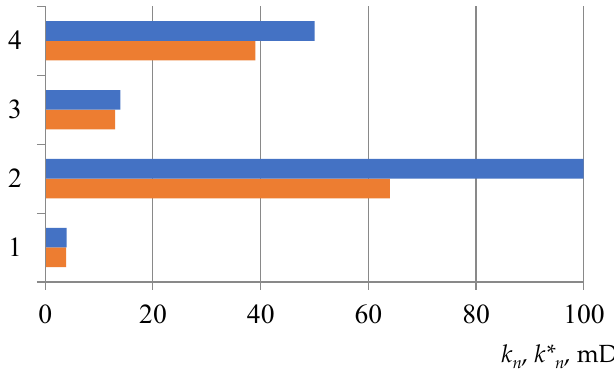
Figure 5. Calculated data on permeability k n , k ∗ n change due to gel treatment for concrete well (blue line stands for k n , orange line stands for k ∗ n ).